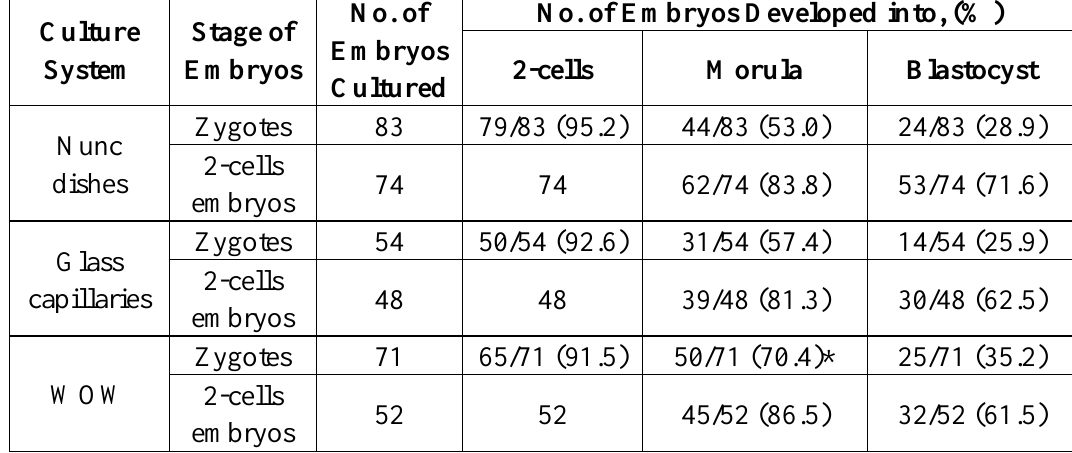
Table 4 . In vitro development of rat embryos using various culture